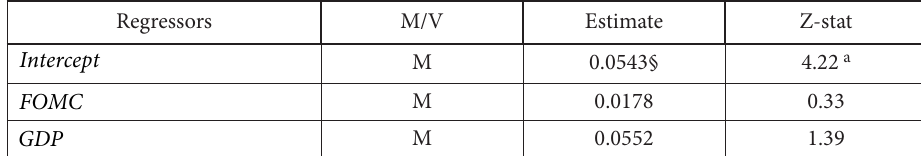
Table 6. Economic policy uncertainty and OEX implied volatility index